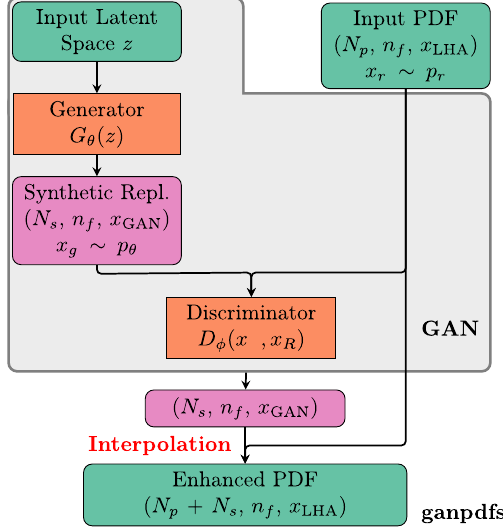
Algorithm 2: Stochastic gradient descent train- ing of the GANs implemented in ganpdfs . Fig. 2 Flowchart describing the combined GANs and compres- sion framework. The ganpdfs code is interfaced with the pyCompressor code from which input arguments related to the enhancement and compression are